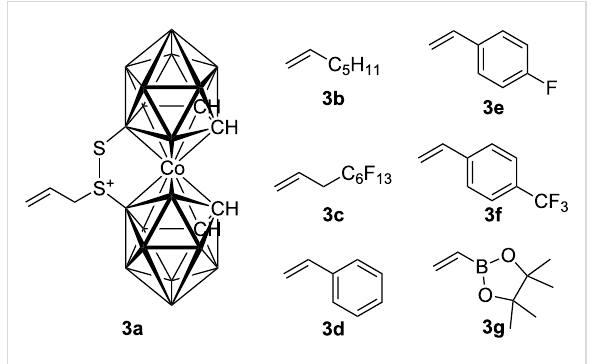
Figure 1: Alkenes 3 used in cross-metathesis reactions with 2 .